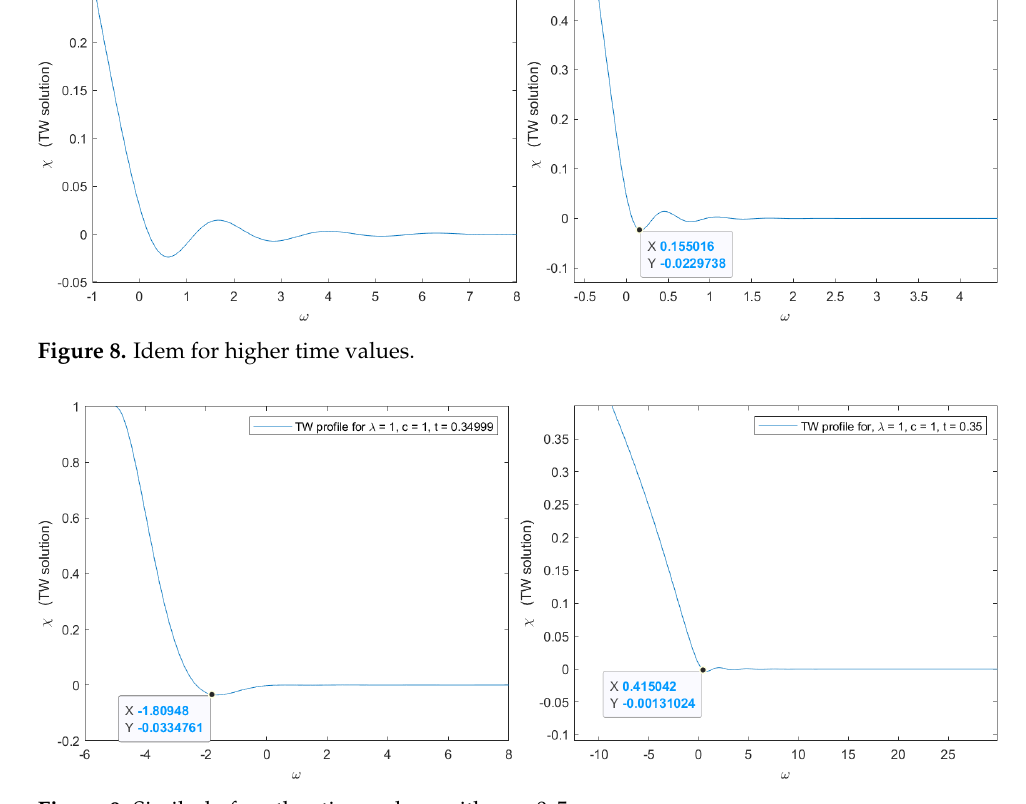
Figure 9. Similarly for other time values with p =